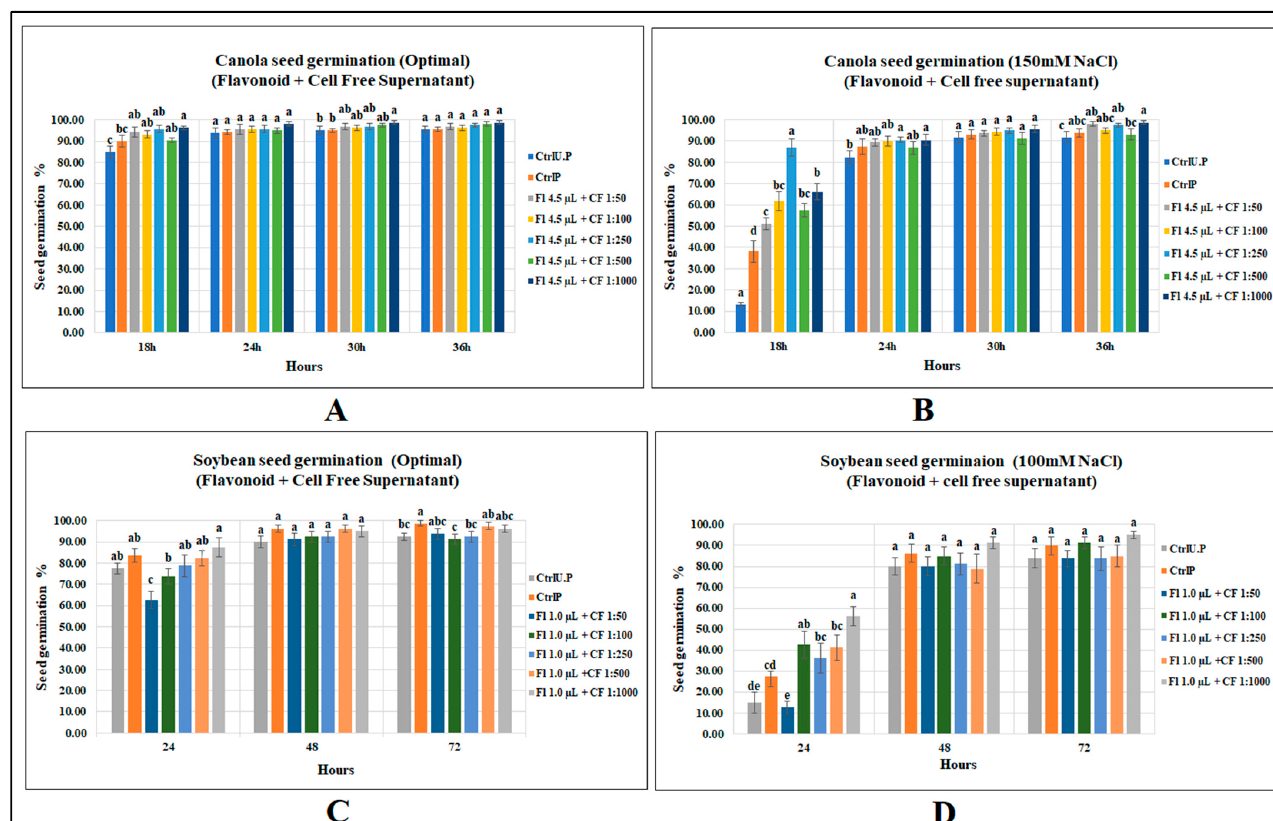
Figure 4. Effect of flavonoids and CFS mixtures: ( A ) canola (optimal growth), ( B ) canola (150 mM NaCl), ( C ) soybean (optimal), ( D ) soybean (120 mM NaCl) . Data shown as mean ± SE of 8 biological replicates; different letters indicate values determined by Tukey’s multiple mean comparison to be significantly different ( p < 0.05) among treatments.